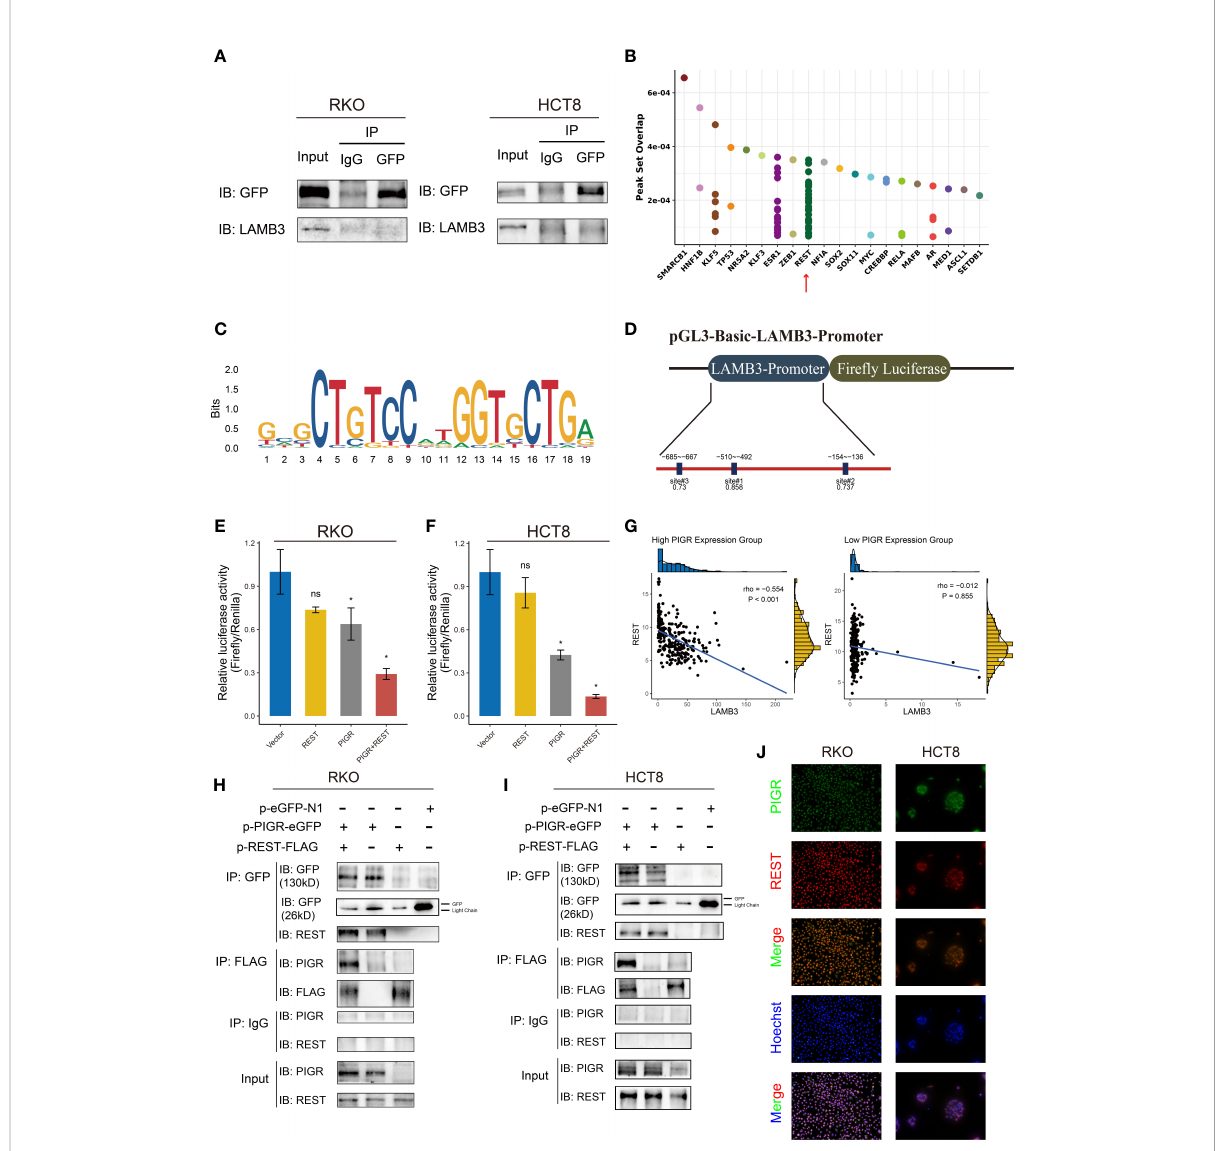
FIGURE 6 REST transcriptionally downregulated LAMB3 by interacting with PIGR (A) Co-immunoprecipitation assays detected the interaction between PIGR and LAMB3. IgG was used as control. (B) Predicted transcription factors bind to LAMB3 promoter using Cistrome database. (C) The binding motif of REST. (D) Schematic description of luciferase reporter and candidate REST binding sites in LAMB3 promoter. (E, F) Relative luciferase activities of LAMB3 wild-type promoter of empty vector (Vector), REST-overexpressing (REST), PIGR-overexpressing (PIGR) and co-expression of PIGR and REST (PIGR & REST) in RKO (E) and HCT-8 (F) cells. Differences compared with Vector group. (G) Correlation between expression of REST and LAMB3 in high PIGR expression group and low PIGR expression group. (H, I) Co-immunoprecipitation assays detected the interaction between PIGR and REST in RKO (H) and HCT-8 (I) cells. (J) The co-localization of PIGR and REST was con fi rmed by fl uorescence microscopy. Data are presented as the mean ± S.D. ns, not signi fi cant; * P <